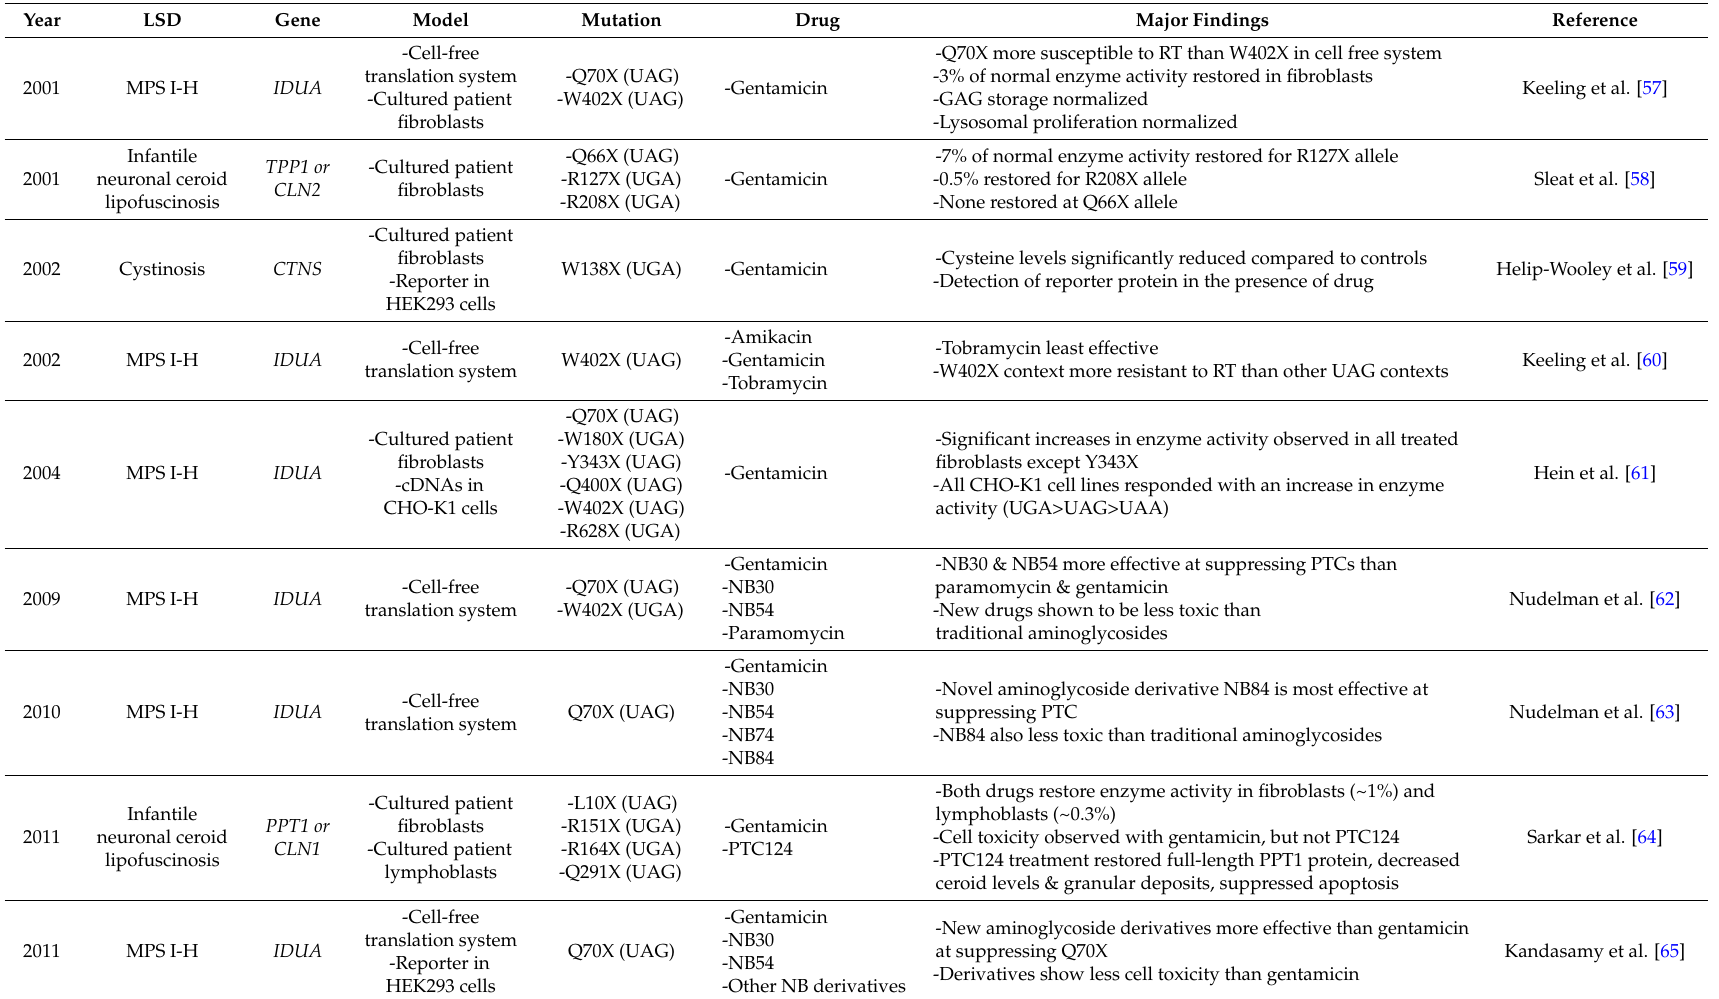
Table 1. Nonsense Suppression Studies in lysosomal storage diseases (LSD)